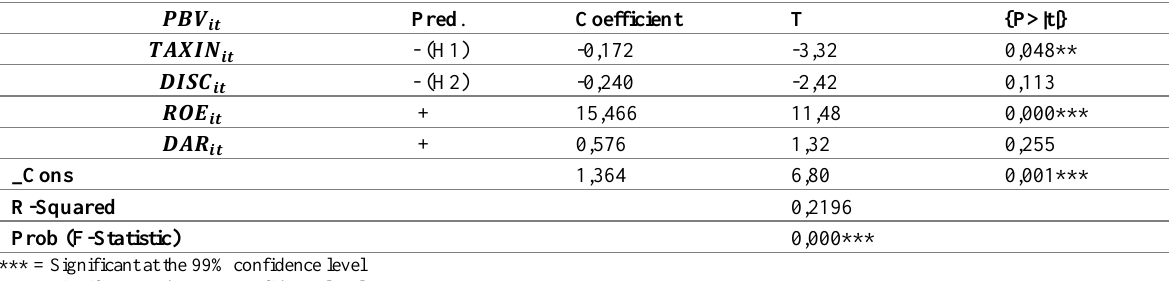
Table 4 : Regression Results Generalized Least Square